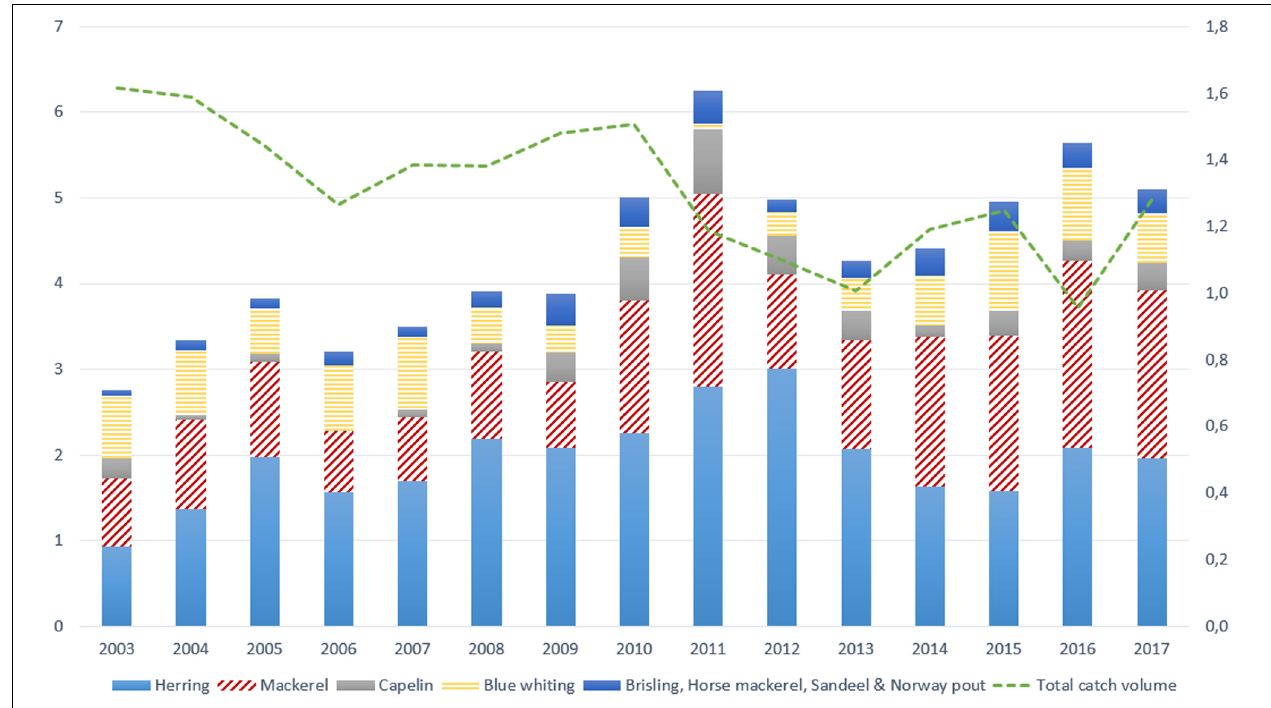
FIGURE 2 | Left axis: Revenue in billion NOK of pelagic species of vessels > 28 m. Right axis: Total catch in billion kilos of pelagic species of vessels > 28 m. Source: Norges Sildesalgslag